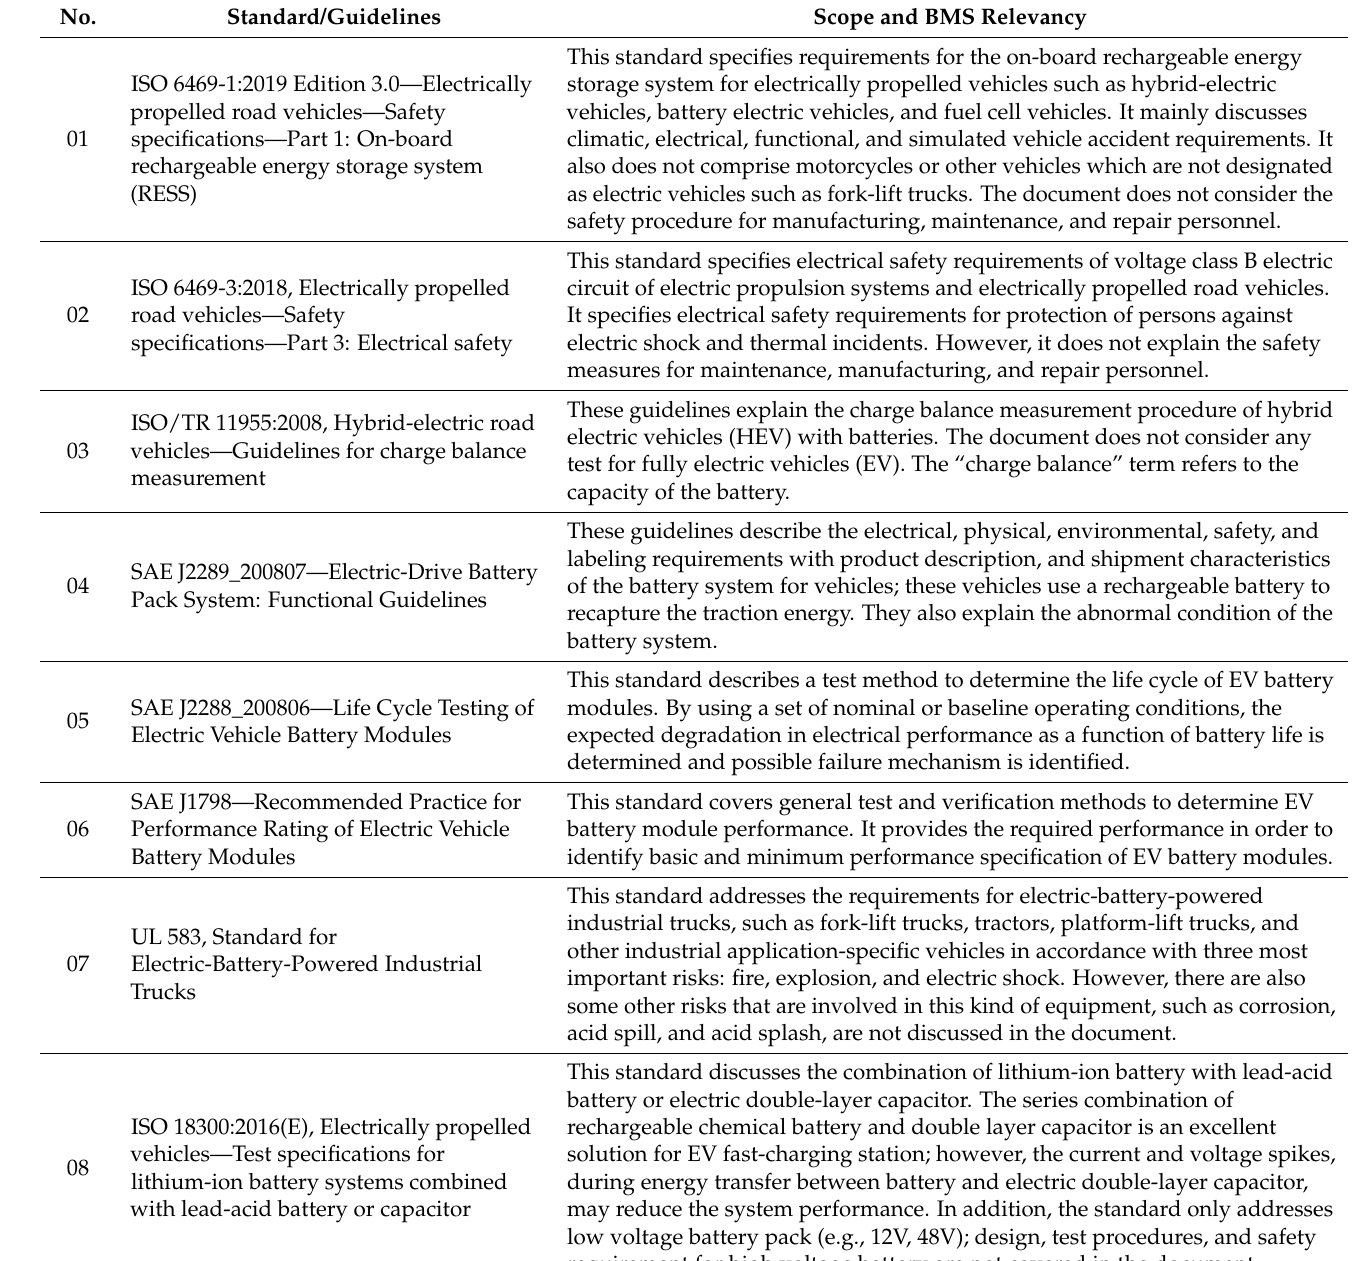
Table 5. Relevant standards/guidelines for transportation